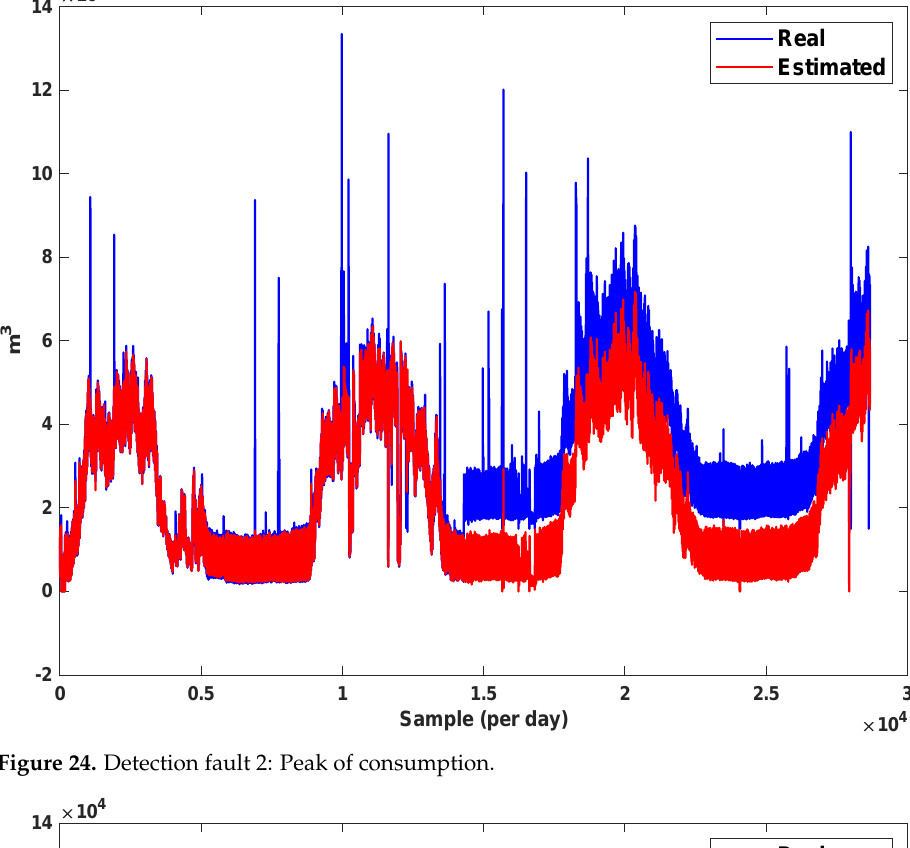
Figure 24. Detection fault 2: Peak of consumption.